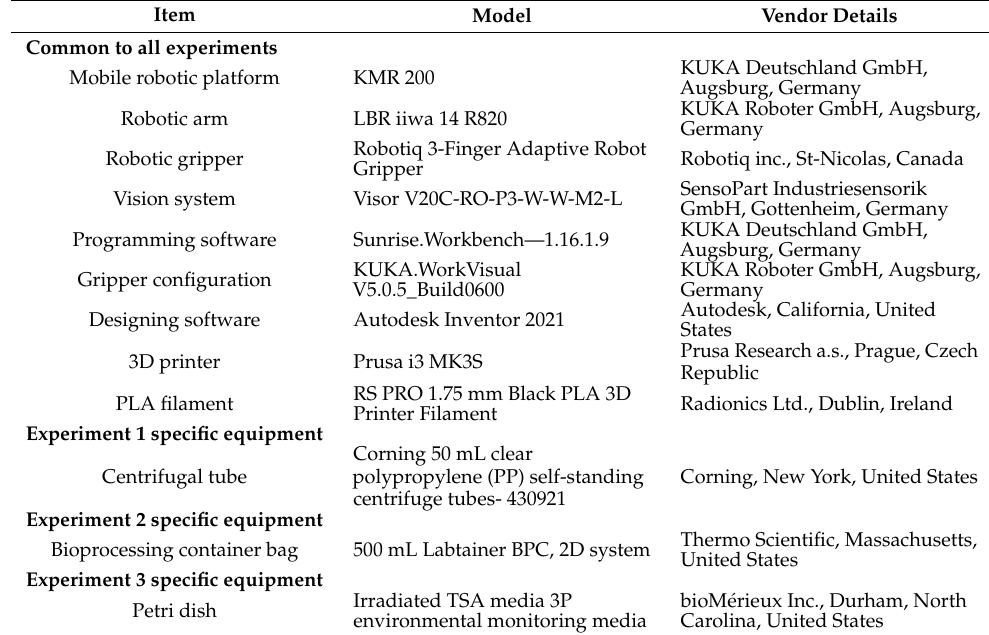
Table 5. List of equipment used in the